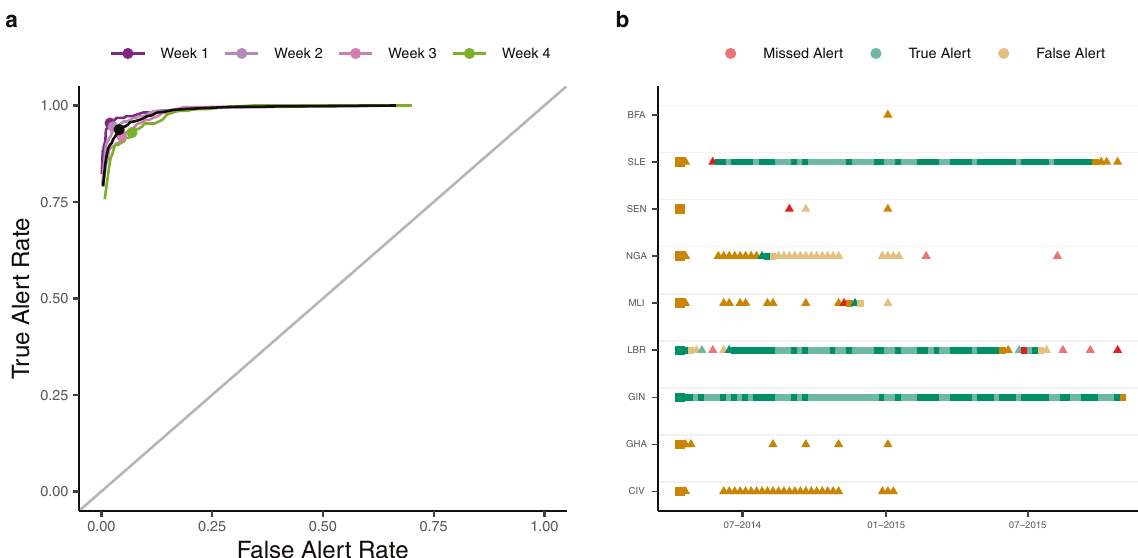
Fig. 2 Predicted weekly presence of cases in each country. a The True and False alert rates using different thresholds for classi fi cation for alerts raised 1 (violet), 2 (light violet), 3 (dark pink) and 4 (green) weeks ahead. The black curve depicts the overall True and False alert rates. On each curve, the dot shows the True and False Alert rates at 42.5% threshold. For a given threshold ( x th percentile of the forecast interval), we de fi ned a True alert for a week where the x th percentile of the forecast interval and the observed incidence for a country were both greater than 0; false alert for a week where the threshold for a country was greater than 0 but the observed incidence for that country was 0; and missed alert for a week where the threshold for a country was 0 but the observed incidence for that country was greater than 0. True alert rate is the ratio of correctly classi fi ed true alerts to the total number of true and missed alerts (i.e., (true alerts)/(true alerts + missed alerts)). False alert rate is similarly the ratio of false alerts to the total number of false alerts and weeks of no alert (where the observed and the threshold incidence are both 0). b The True (green), False (orange) and Missed (red) 1 week ahead alerts using the 42.5th percentile of the forecast interval as threshold. The fi gure only shows countries on the African continent for which either the 42.5th percentile of the predicted incidence or the observed incidence was greater than 0 at least once. The fi rst alert in each country is shown using larger squares. Alerts in a country in a week where there were no observed cases in the previous week are shown using triangles. In each case, weeks for which all observed points were imputed are shown in lighter shades. Country codes, shown on the y-axis, are as follows: CIV Côte d'Ivoire, GHA Ghana, GIN Guinea, LBR Liberia, MLI Mali, NGA Nigeria, SEN Senegal, SLE Sierra Leone, BFA Burkina Faso. The alerts are based on forecasts using ProMED data, a 2-week calibration window and a 4 week forecast Risk of spatial spread . A spatially explicit branching process model (see Methods) was used to forecast short-term future incidence and predict the presence or absence of cases in a country. For each week and each country in Africa, our model generated an alert if the predicted incidence (using a predeter- mined percentile of the forecast interval) was greater than 0. We classi fi ed an alert for a given week as a true alert when the observed incidence was also greater than 0, as a false alert when no cases were observed, and as a missed alert if cases were observed but were not predicted by the model. Using different percentiles of the forecast (e.g., the median or the 95th percentile) yielded different rates of true, false and missed alerts, which were summarised in a ROC curve. We found that the model allowed us to robustly predict the presence or absence of cases in all countries up to a week in advance. Overall, our model achieved high sensitivity (i.e., true alert rate) but variable speci fi city (i.e., 1 - false alert rate). Maximising the average between sensitivity and speci fi city led to 93.7% sensitivity and 96.0% speci fi city at 42.5% threshold (Fig. 2a). The sensitivity of the model remained high over a longer forecast horizon while the speci fi city deteriorated with more false alerts being raised 4 weeks ahead (Supplementary Fig. 47). We tested the performance of the model in predicting the presence of cases in countries other than the three majorly affected countries (Guinea, Liberia and Sierra Leone). Both the sensitivity and the speci fi city of the model remained high under this more stringent criterion. The average of sensitivity and speci fi city was maximum at 92.5% threshold in this case with 85.7% sensitivity and 81.7% speci fi city (Supplementary Fig. 48). Similarly, the model exhibited high sensitivity (83.3%) and